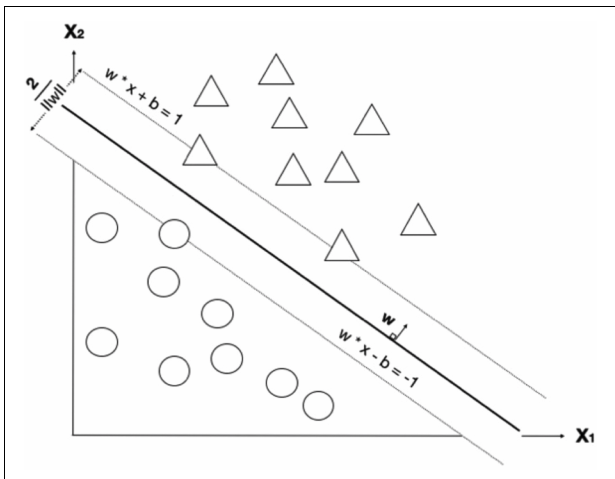
FIGURE 4 | A decision boundary for support vector machine (SVM) that tries to maximize the boundary between two classes. Image shows a maximum-margin hyperplane and margin for an SVM trained on two classes. Samples on margins are called support vectors. x refers to each feature; there are two features in this example (x 1 and x 2 ). Each circle refers to a datum point, where blue and green refer to different classes. There are two learning parameters from the model; w and b are weights and bias, respectively. The margin between the two classes is 2/||w|| .